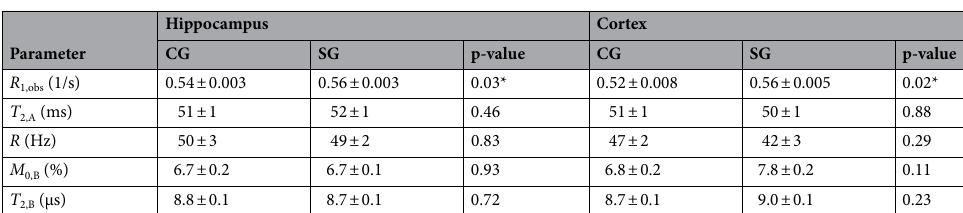
Table 1. The measured observed R 1 R 1,obs (= 1/ T 1,obs ) and estimated parameters of the two-pool MT model. Values (mean ± SEM) obtained from fitting the Z-spectra of control and stressed groups with saturation B 1 s of 3 and 5 µT in the hippocampus and cortex. CG denotes the control group and SG, the stressed group. To compare the results parametric two-tailed Student’s t-test or non-parametric Mann–Whitney U ‐ test (when data did not meet criteria of normal distribution) were performed. *p <